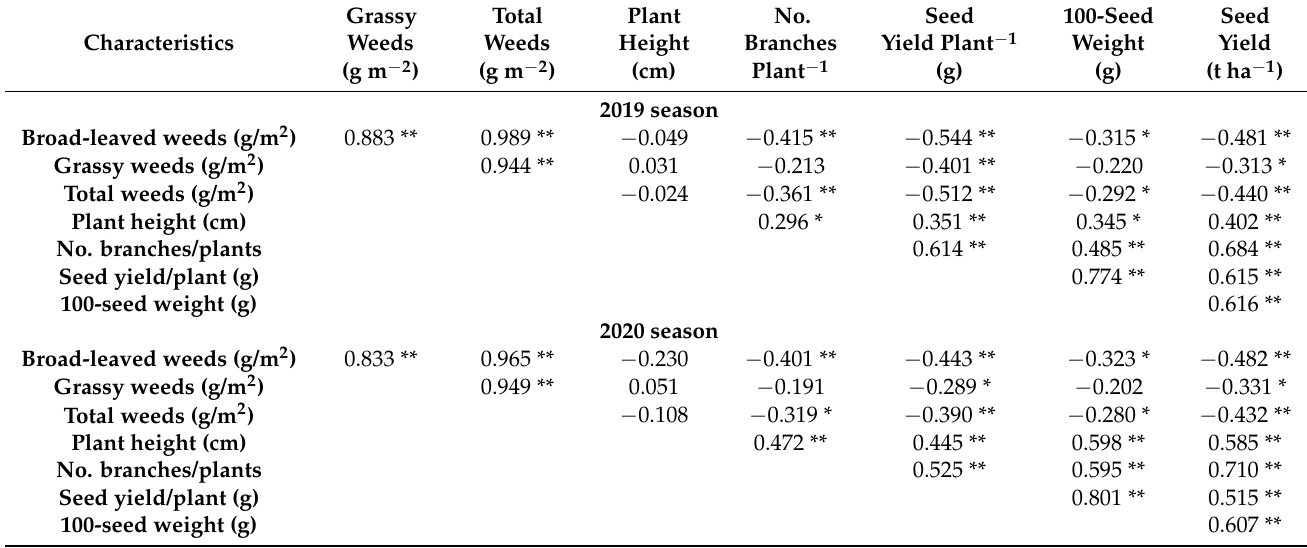
Table 13. Correlation coefficient between the studied characteristics and soybean yield and its components, in 2019 and 2020